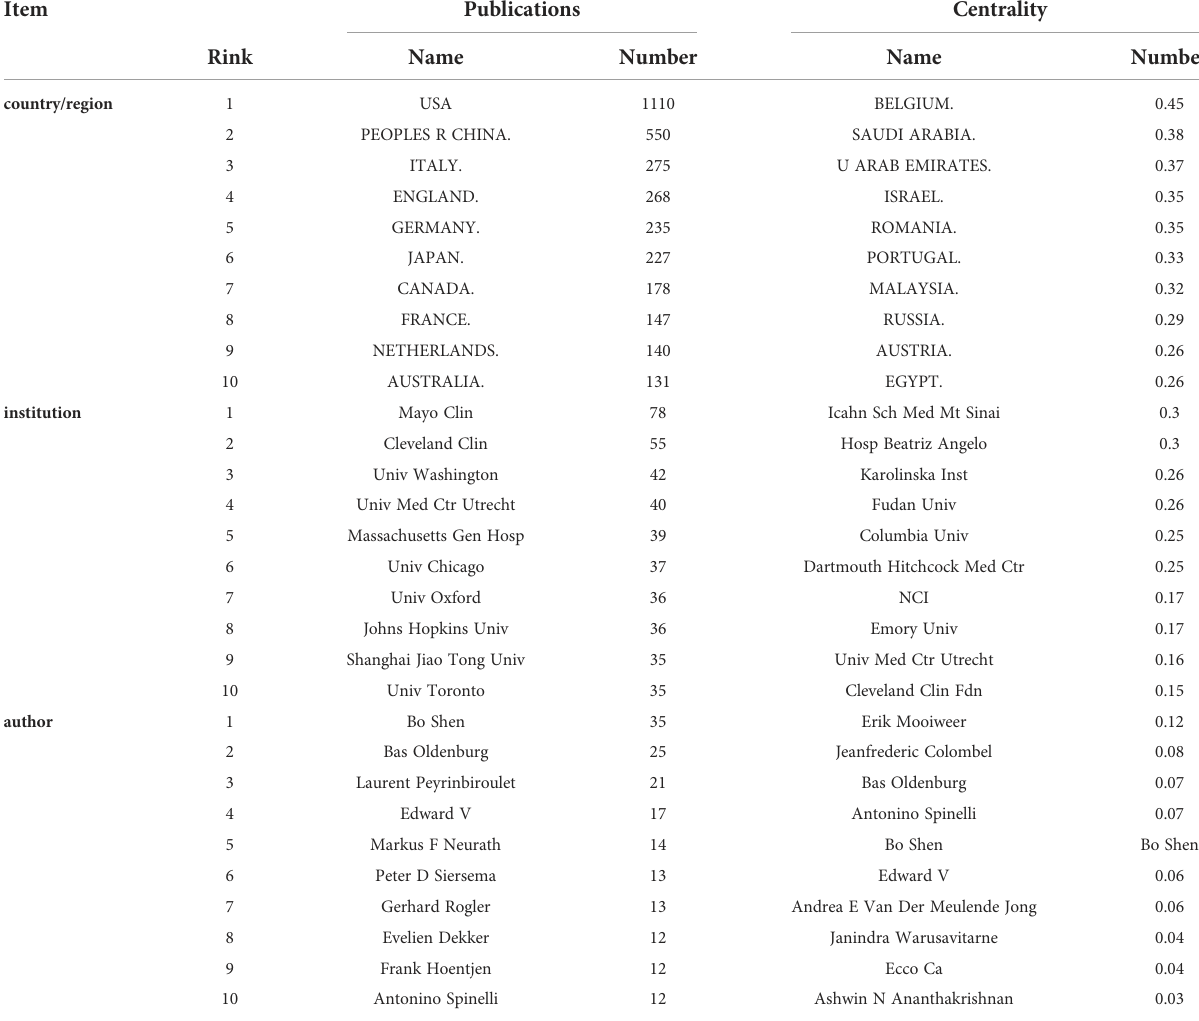
TABLE 1 Top 10 countries/regions, institutions, and authors in terms of publications and centrality.